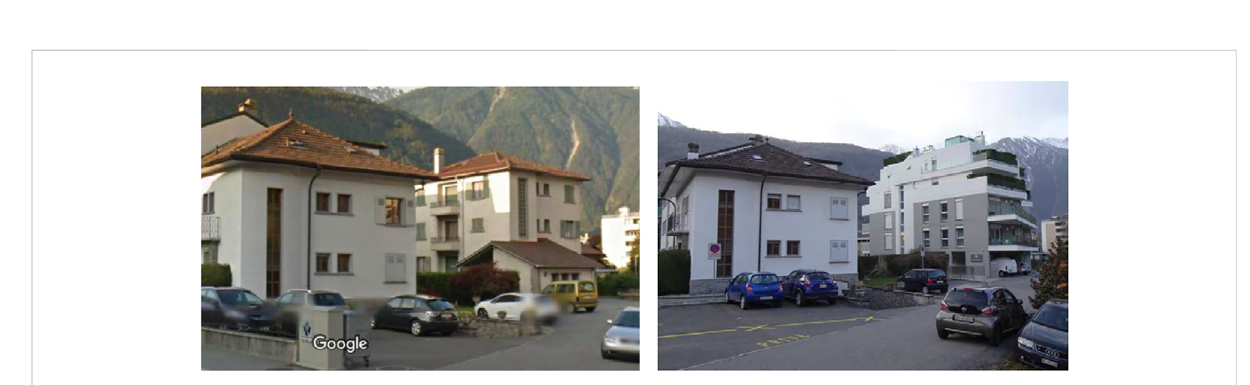
FIGURE 11 Martigny, low-rise URM building (in the background) demolished and replaced by a mid-rise. RC building.